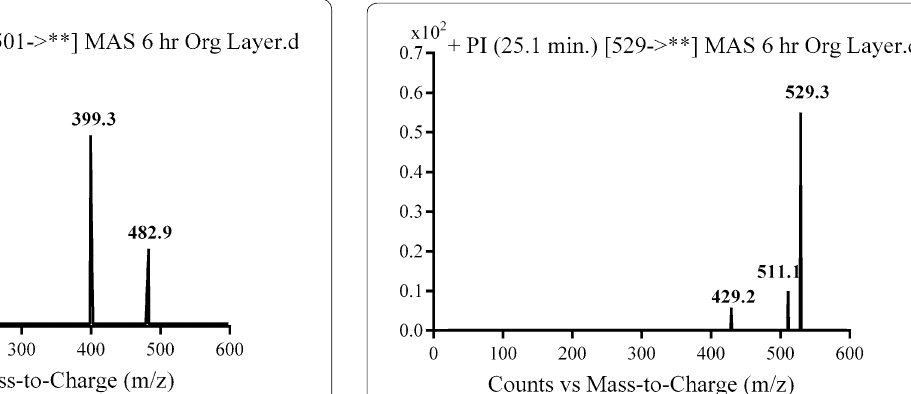
Fig. 6 PI mass spectrum of parent ion (M4) at m/z 501 Fig. 7 PI mass spectrum of parent ion (M5) at m/z